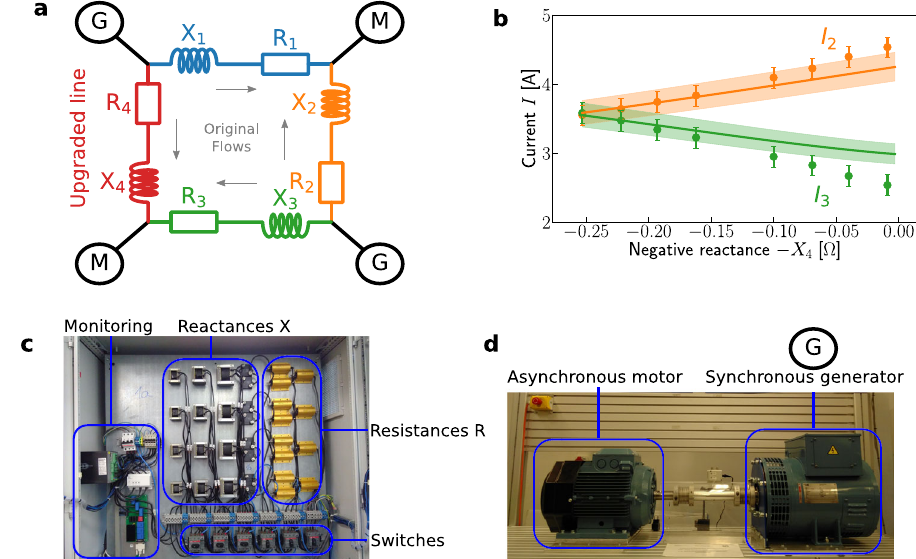
Fig. 2 | Braess ’ paradox in laboratory-scale AC grids. Here, Braess ’ paradox is observableasanincreaseof fl owonthemosthighlyloadedlineduetoupgradinga transmission line in the network. a Schematic of the experimental setup demon- strating Braess ’ paradox with two generators (G) and two motors (M). The reac- tance X 4 ofline4isreduced,effectivelyupgradingtheline. b Thecurrentamplitude I 2 and I 3 on lines 2 and 3 (as examples of lines where the additional fl ow is aligned and anti-aligned to the original fl ow) asa function of the negative reactance − X 4 of the upgraded line 4. While the current on line 3 decreases, line 2 carries an increasing load: Braess ’ paradox occurs. Dots with error bars and shaded regions